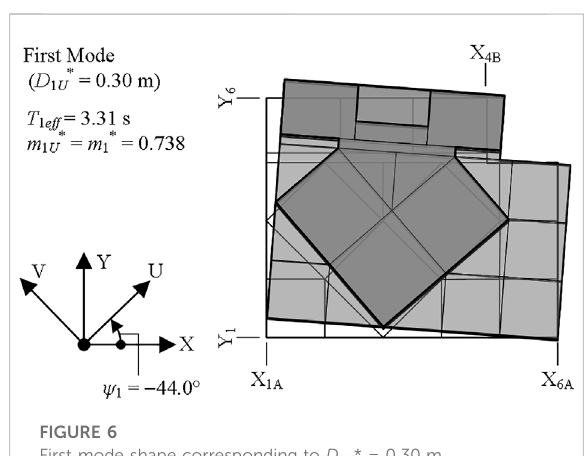
FIGURE 6 First mode shape corresponding to D 1 U * = 0.30